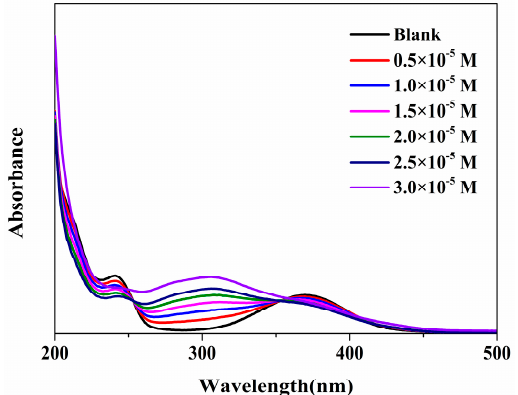
Figure 7. UV-vis. absorption spectra of nitrite at different concentrations added to the N-CQD.